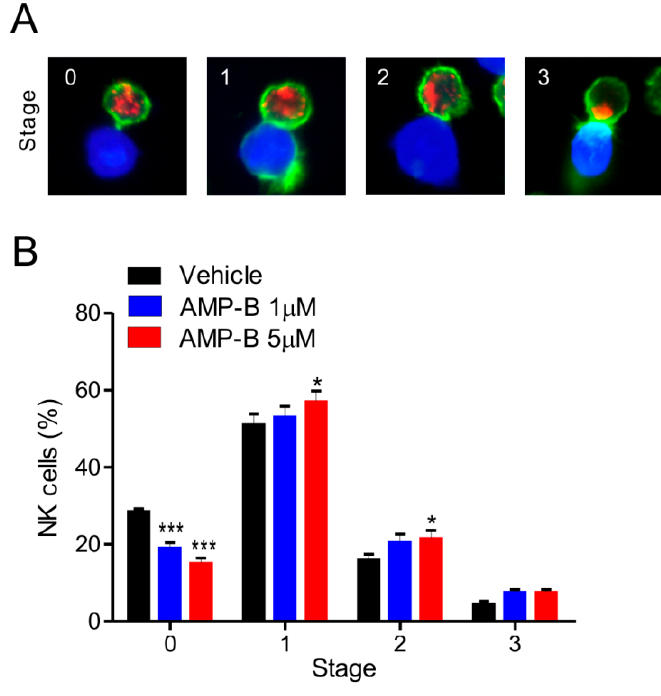
Figure 4. AMP-B increases cytolytic granule polarization toward target cells. ( A ) Representative confocal images of conjugates between NKL cells and CellTracker orange CMTMR-labeled 221 cells ( blue ). Conjugates were fixed, permeabilized, and stained with phalloidin for actin ( green ) and anti-perforin antibody ( red ). Conjugates were then analyzed by confocal microscopy to determine the polarization of perforin-containing granules toward target cells. Conjugates were categorized into different stages according to the progression of granule polarization toward target cells. Shown are conjugates representative of each stage; ( B ) NKL cells pretreated for 30 min with the indicated doses of AMP-B were incubated with CMTMR-loaded 221 cells for 30 min. Cells were then stained as described in ( A ), and the percentages of NKL cells at each stage of granule polarization were measured with at least 100 NKL-target cell conjugates. Summary graphs of statistical line charts are shown. * p < 0.05 and *** p < 0.001.